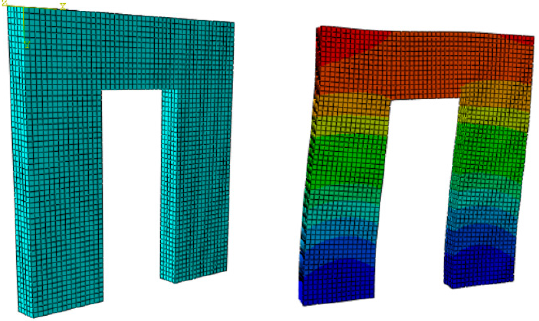
Figure 9. FE model and deformation pattern of specimen 1-3.